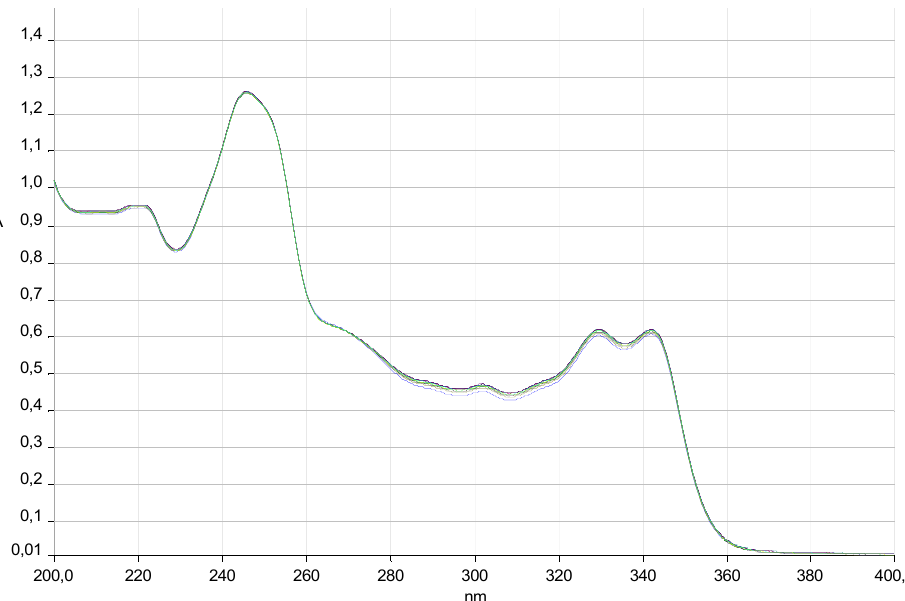
Figure 3. UV spectra of compound 6a in aqueous solution at different times of incubation (0 to 4 h, measured every 15